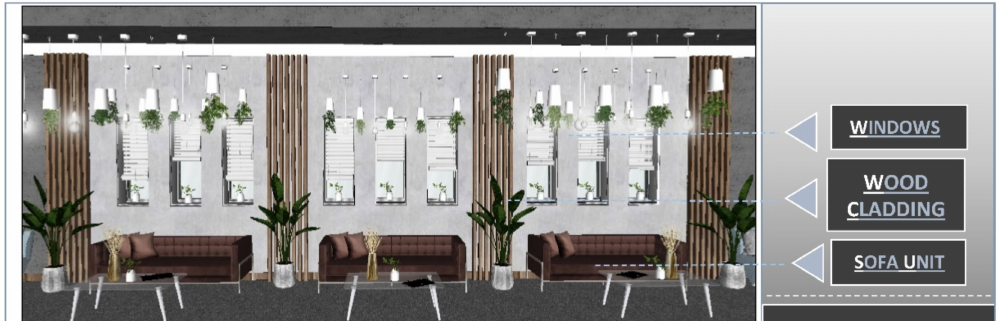
Figure 24. The picture shows the proposed design of break